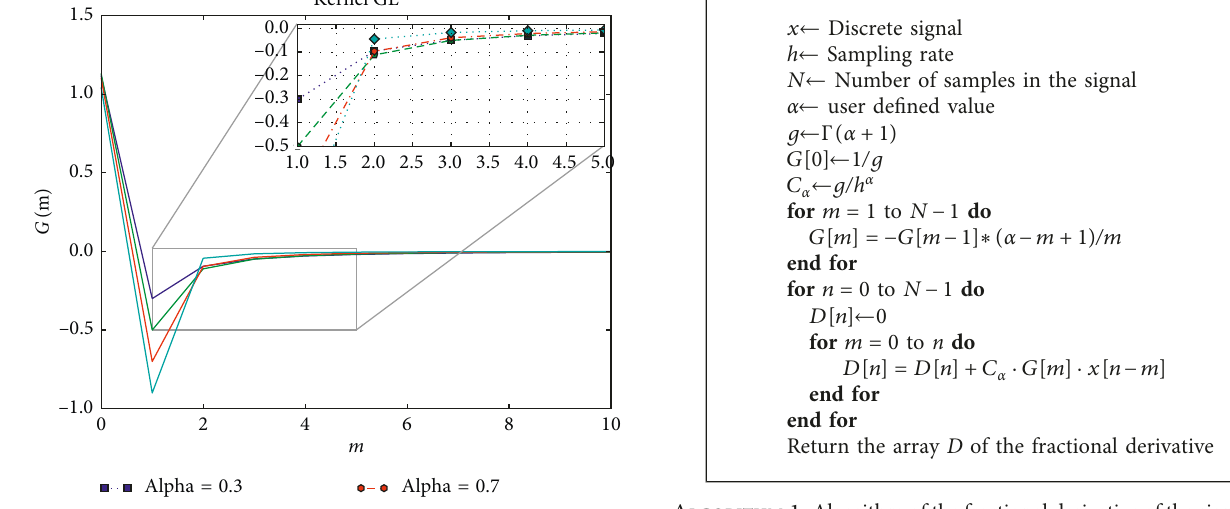
A LGORITHM 1: Algorithm of the fractional derivative of the signal as the Cauchy finite discrete convolution with the GL dynamic m ) under different ( )